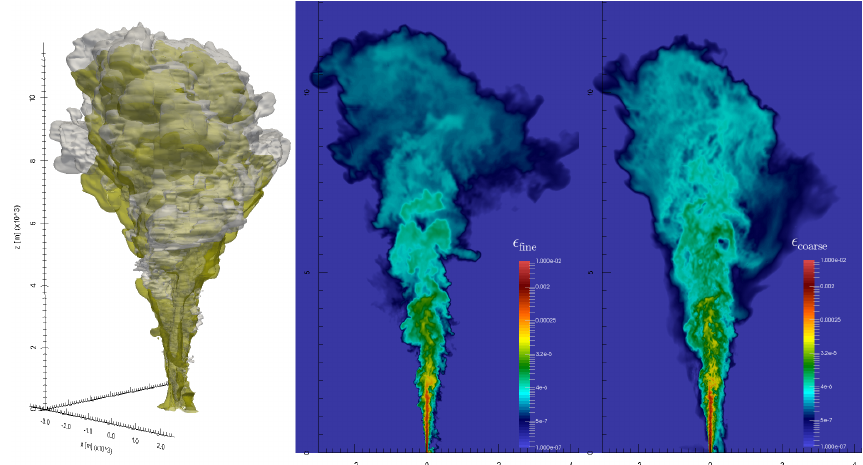
Figure 18. Three-dimensional numerical simulation of a weak volcanic plume, 400s after the beginning of the injection (inlet conditions as in Table 2). The isosurfaces (left) represent fine (light gray) and coarse (light sand) ash volume fractions (cid:15) s = 10 − 7 . The two-dimensional plots represent the distribution of the volume concentration of fine (center) and coarse (right) particles across a vertical orthogonal slice crossing the plume axis.